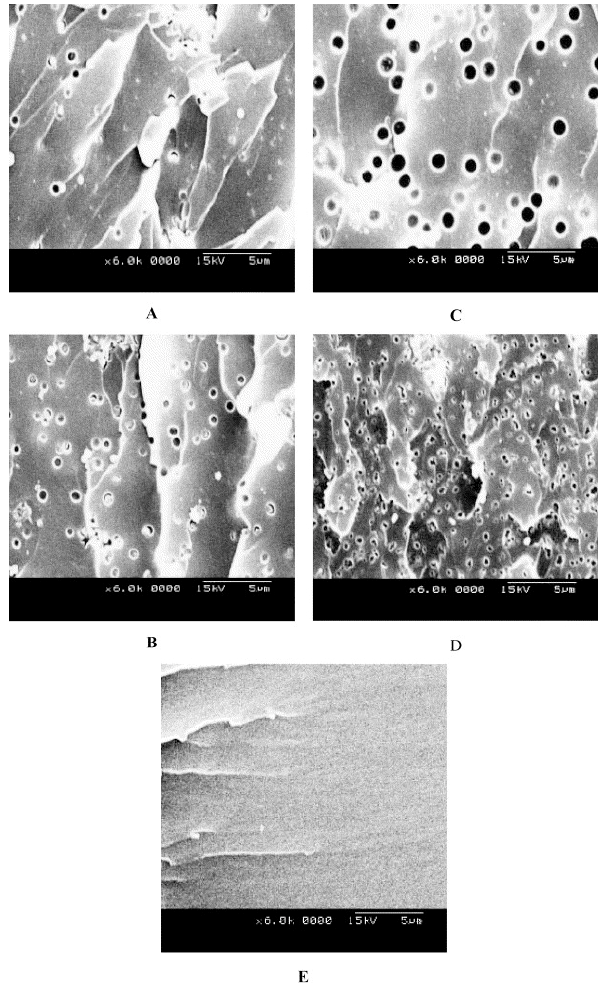
Figure 3. SEM images of epoxy nanocomposites containing ( A ) 5 wt.% of octanitrophenyl-POSS (ONP-POSS), ( B ) 10 wt.% of ONP-POSS, ( C ) 15 wt.% of ONP-POSS, ( D ) 20 wt.% of ONP-POSS, and ( E ) 10 wt.% of